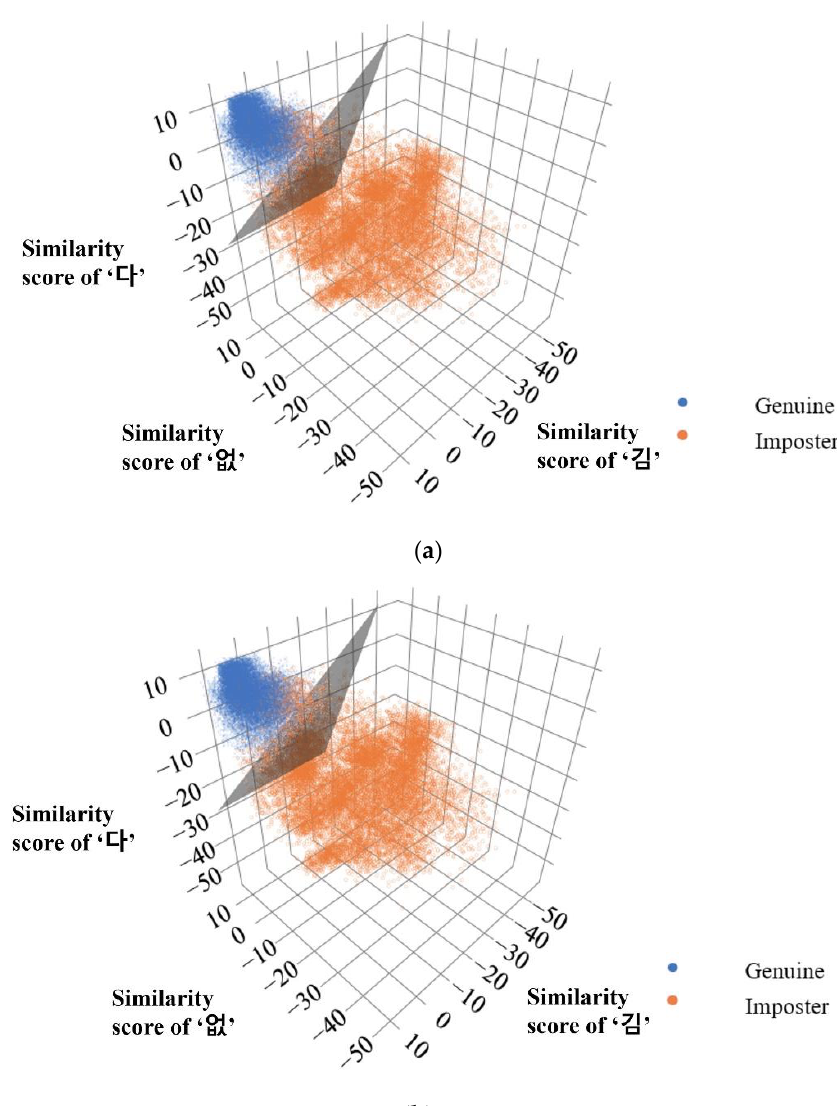
Figure 8. Scatter plots of multimodal of three characters with a classifier: ( a ) linear kernel boundary; ( b ) RBF kernel boundary.